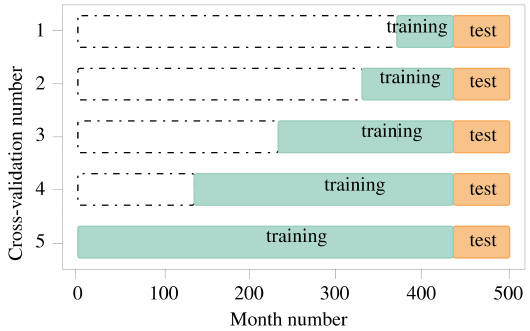
Figure 12. Schematic of the five folds cross-validations.